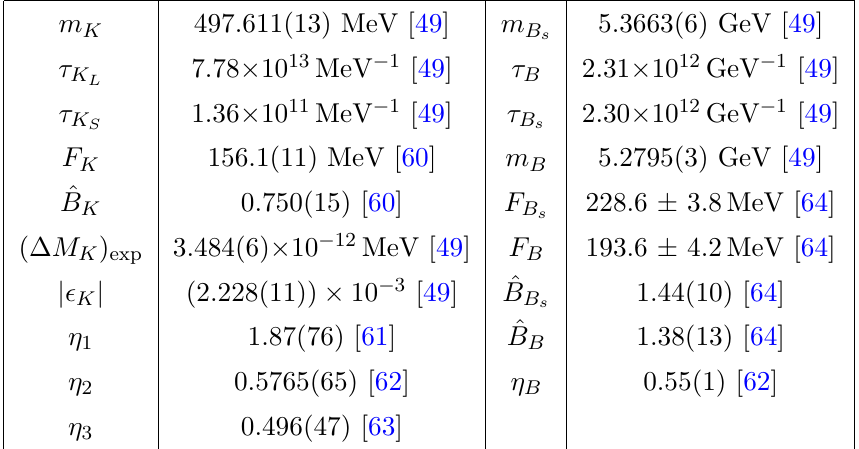
Table 4 . The input parameters relevant to our analyses on (cid:13)avor